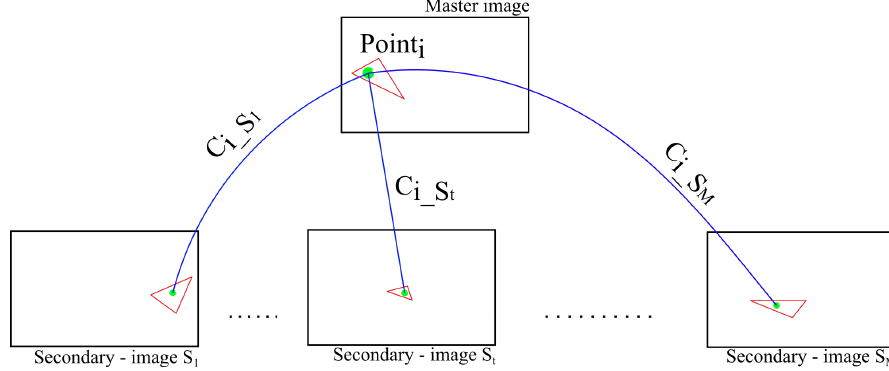
Figure 13. Computation of Global Correlation Score ( C GCS